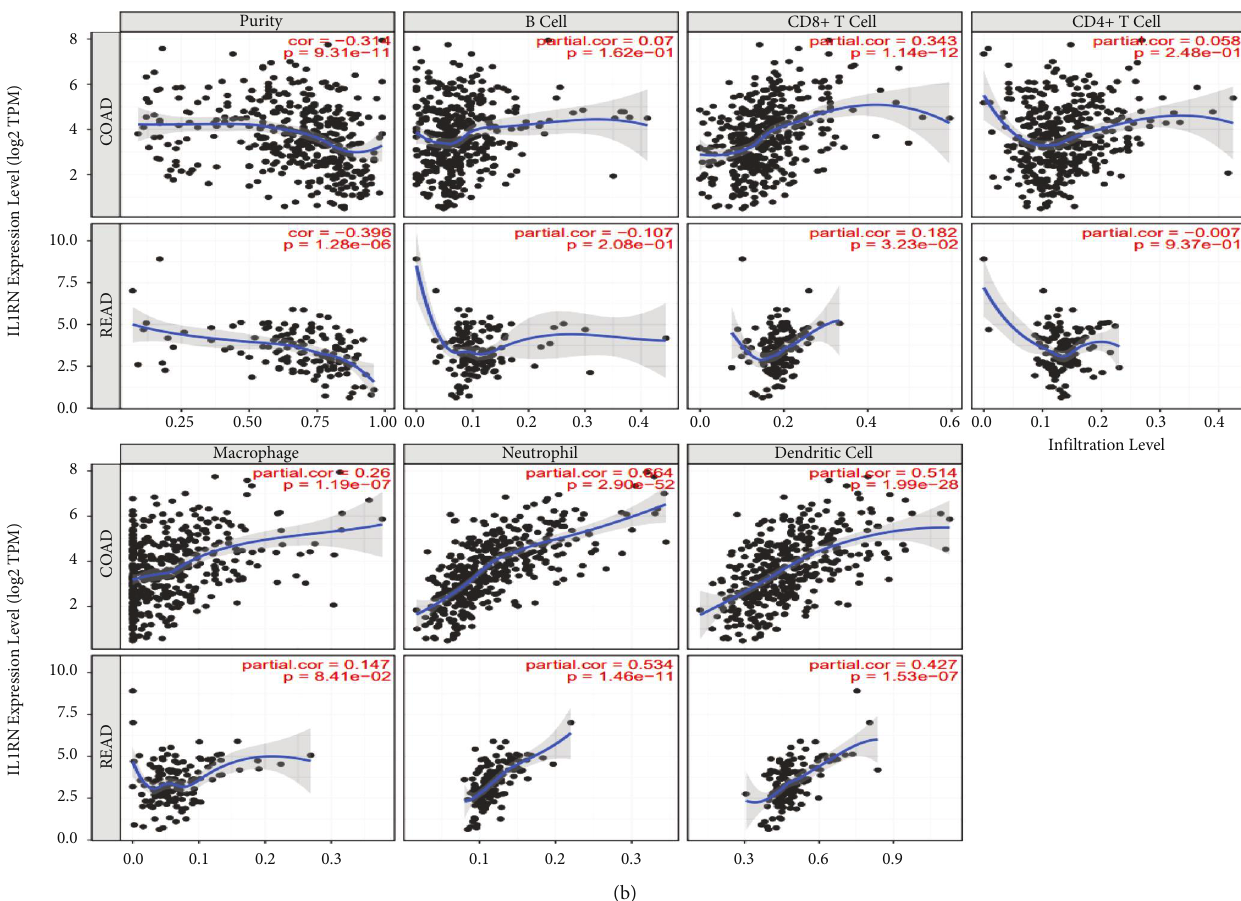
Figure 7: Correlation of IL1RN and PRRX1 expression with immune in fi ltration in CRC. (a) and (b) Correlation of IL1RN and PRRX1 expression with in fi ltration levels of TILs CRC available at TIMER2.0 database. TILs, tumor-in fi ltrating lymphocytes; TIMER2.0, Tumor Immune Estimation